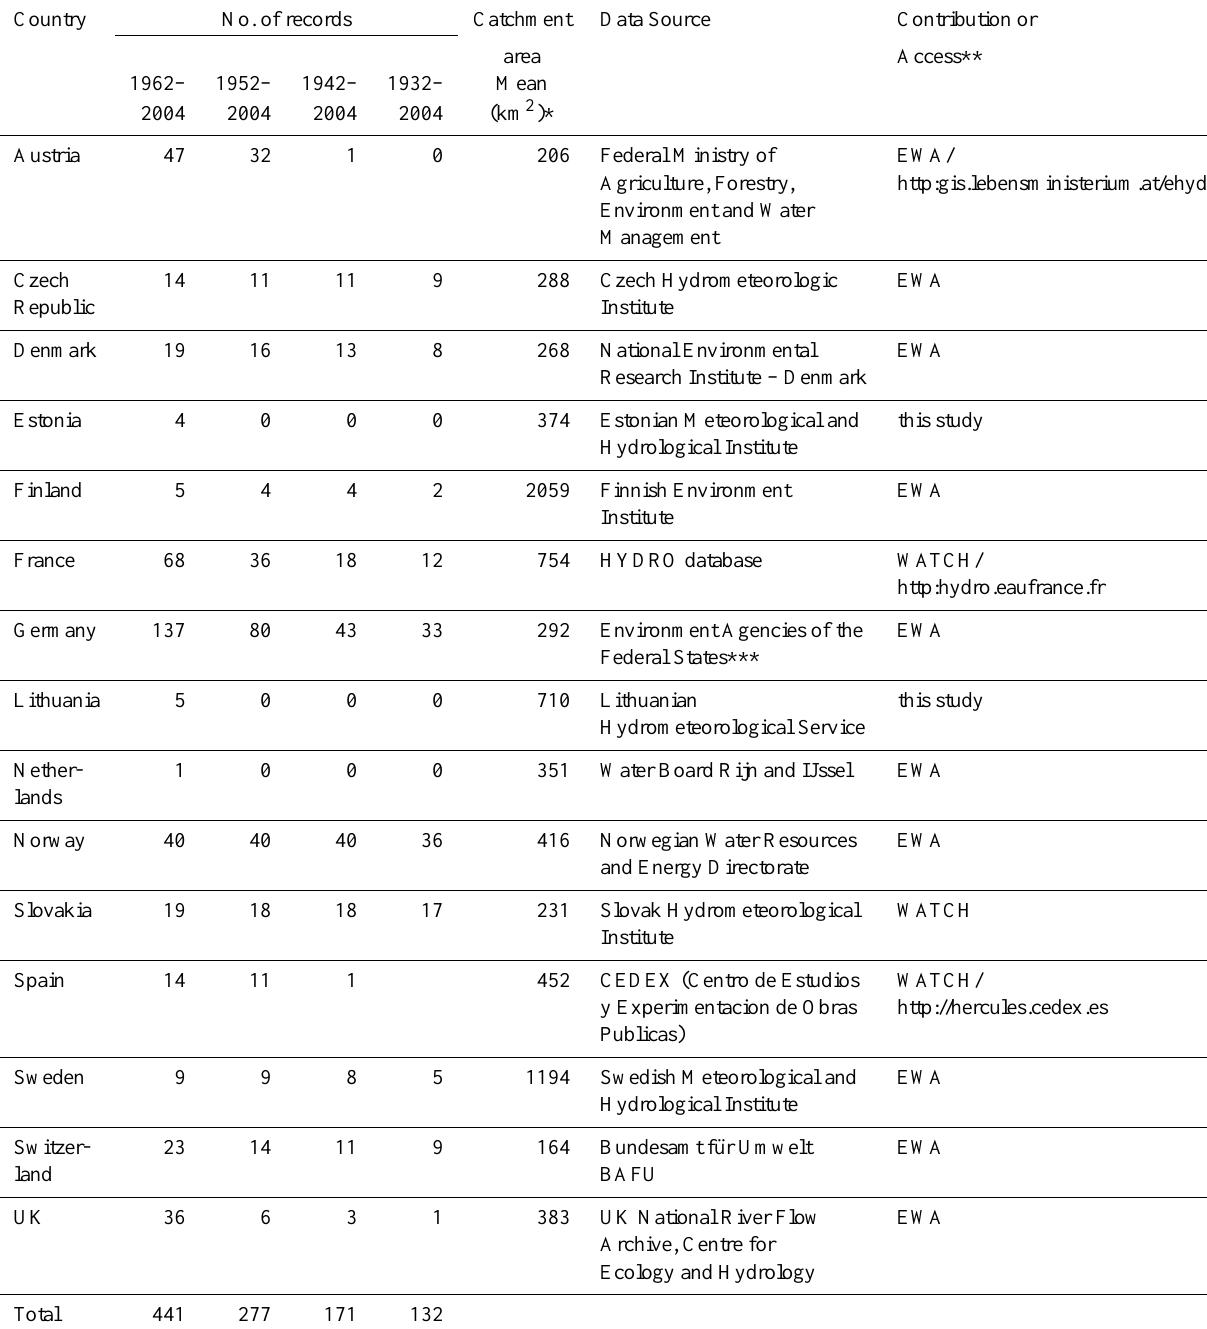
Table 1. Streamflow dataset.